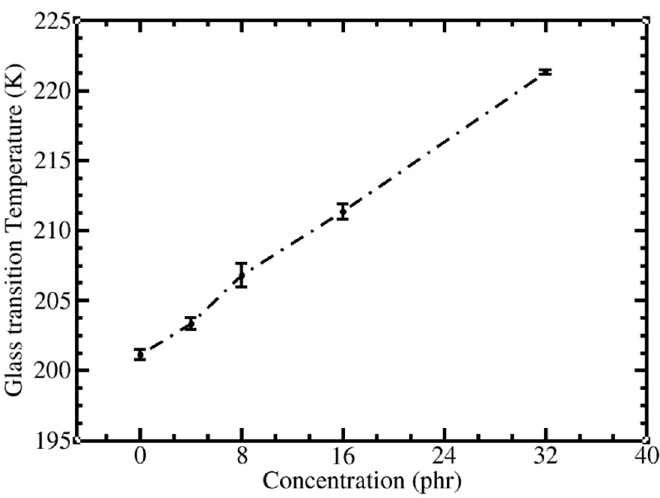
Figure 6. Glass transition temperature (T g ) of cis -PI-C 60 composites at different C 60 concentrations.